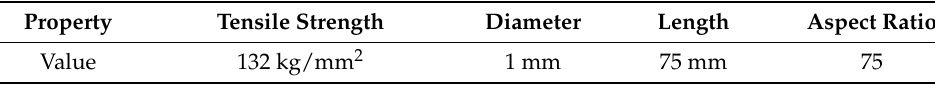
Figure 3. Steel fibers extracted from used tyres. Table 3. Properties of steel fibers.